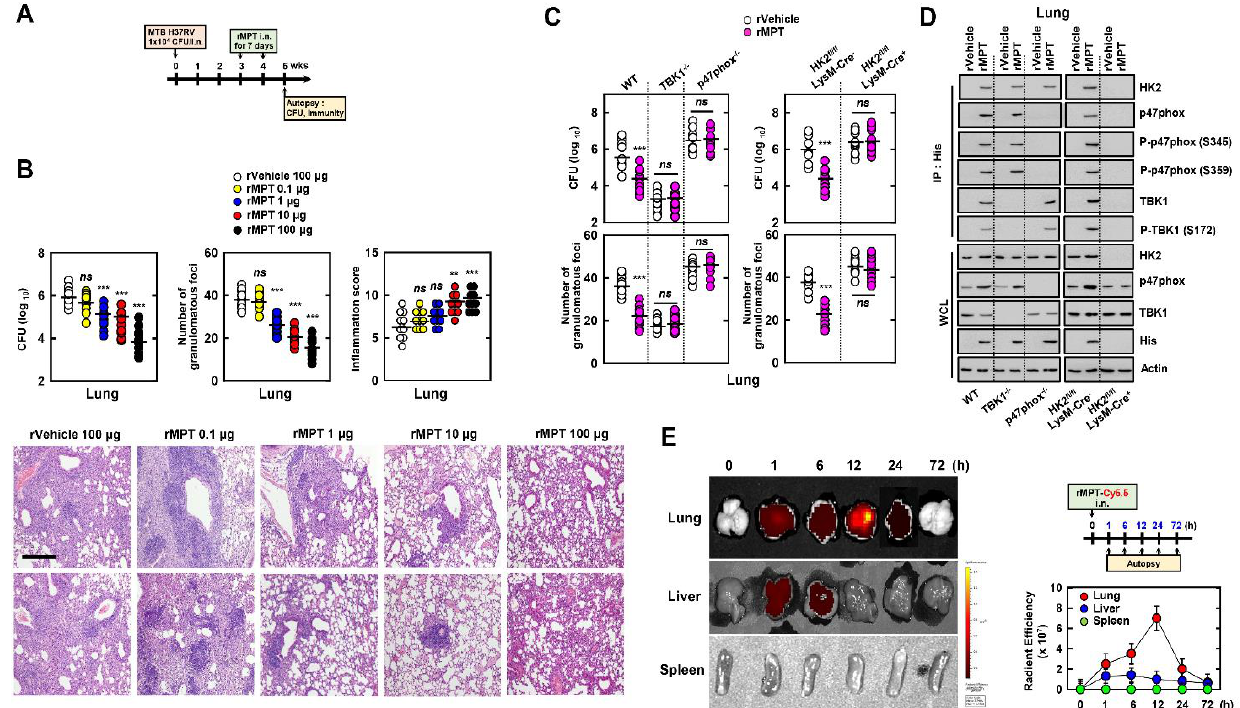
Figure 8. rMPT is a potential therapeutic agent against MTB in mice. ( A ) Schematic of TB model treated with rMPT or rVehicle. Mice (n = 10 per group) were intranasally infected by MTB H37Rv (1 × 10 4 CFU/mice). After 3 wks, mice were treated with rMPT or rVehicle for 7 d. Immunological analysis conducted in 5 wks. ( B ) Bacterial loads, the number of granuloma, and the level of inflammation were analyzed in each group of mice lungs (upper). Histopathology scores were obtained from H&E stained lung sections (bottom). Scale bar, 500 µ m. ( C ) Bacterial loads were counted in WT, TBK − / − , and p47phox − / − HK2 fl/fl LysM-Cre − , and HK2 fl/fl LysM-Cre + mice lung. ( D ) Lung harvests in each group of mice were used for IP with His-agarose bead, followed by IB with α HK2, α p47phox, α P-p47phox (S345 and S359), α TBK1, and α P-TBK1 (S172). WCLs were used for IB with α HK2, α p47phox, α TBK1, α His, and α Actin. ( E ) Fluorescence images of the lung, liver, and spleen of the mice intranasally administrated with Cy5.5 labelled-rMPT (left), and quantitative fluorescence intensities of the organs measured by an IVIS spectrum-chromatography (CT) system. The data are representative of four independent experiments with similar results ( B – E ). Significant differences (* p < 0.05, ** p < 0.01; *** p < 0.001) compared with rVector-treated